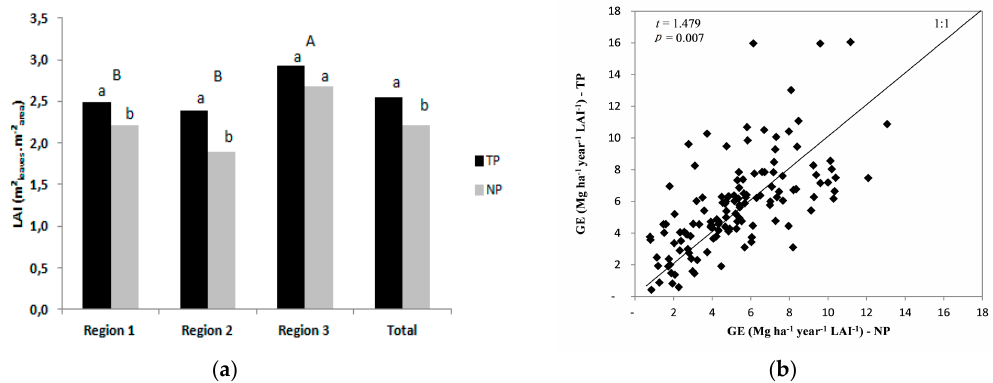
Figure 5. ( a ) Average LAI for each region and treatment. Bars with identical letters are not significantly different. Lowercase letters represent the comparisons of treatments and uppercase letters represent the differences between regions ( p = 0.05); ( b ) Correlation between growth efficiency (GE) in twin plots (TP) and normal plots (NP).